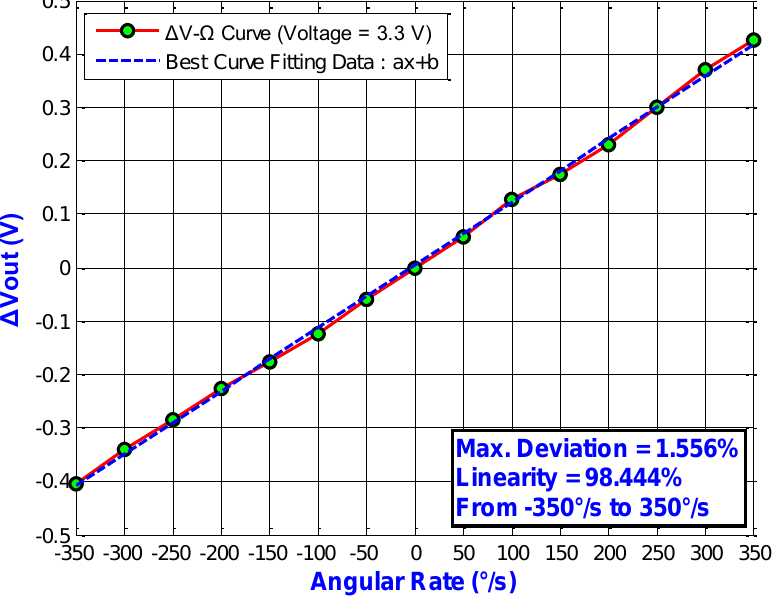
Figure 20. Output voltage of the gyroscope under different angular rates.